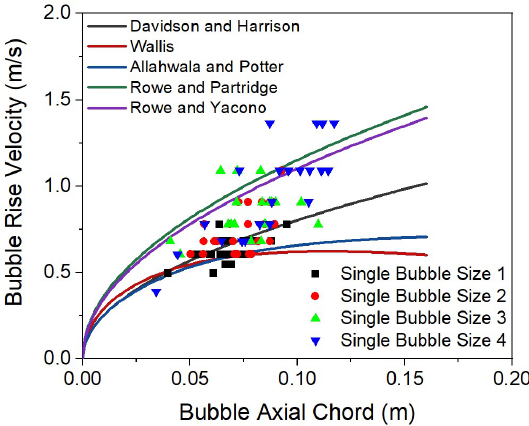
Figure 3. Single bubbles of four different sizes, fitting a band delimited by various available models. Sizes 1 to 4 were 336 × 10 −6 m 3 , 433 × 10 −6 m 3 , 529 × 10 −6 m 3 , 626 × 10 −6 m 3 , respectively [19].